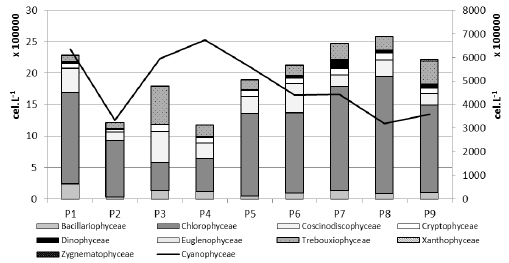
Figure 3. Density of the phytoplankton community from Broa reservoir in 9 points (P1 to P9) along a longitudinal transect. The primary axis includes all phytoplankton classes, with the exception of the class Cyanophyceae, which is allocated on the secondary